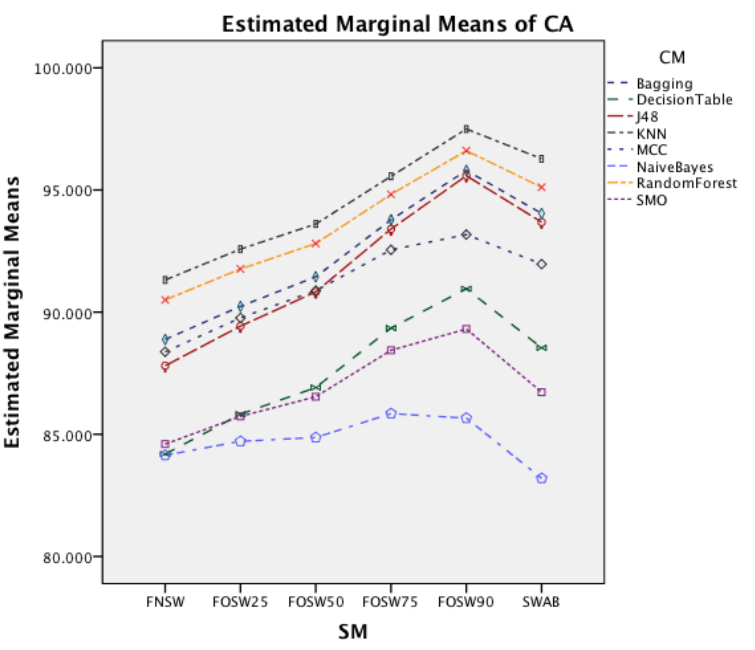
Figure 5. Two-way interaction effect for SM and